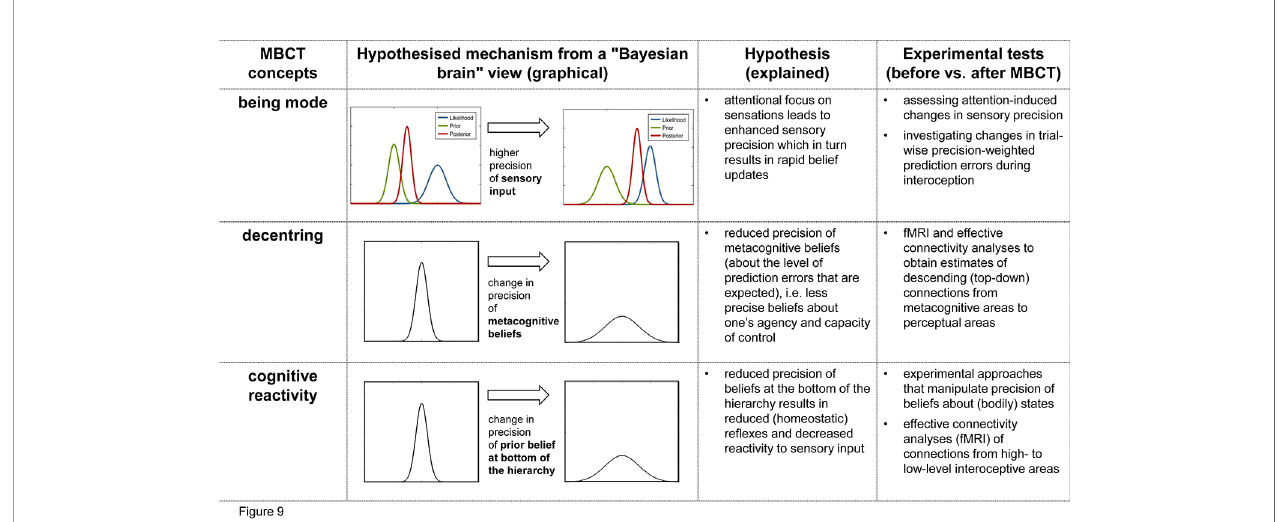
FIGURE 9 | Summary of the hypotheses presentedin this paper and the proposed experimentaltests. This fi gure relates key concepts from MBCT ( fi rst column) to a proposed Bayesian brain perspective ofits mechanisms(second column),a brief summaryof this hypothesis (third column), and possibleexperimentaltests (fourth